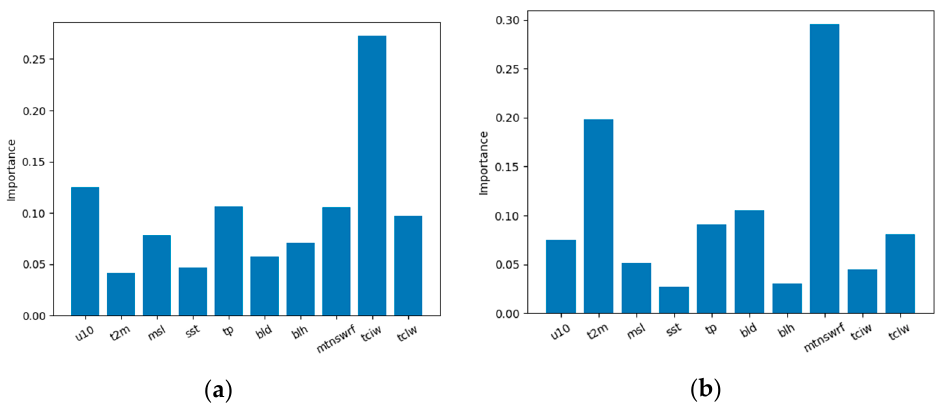
Figure 13. Feature importance of candidate meteorological factors ( a ) fall; ( b ) winter.